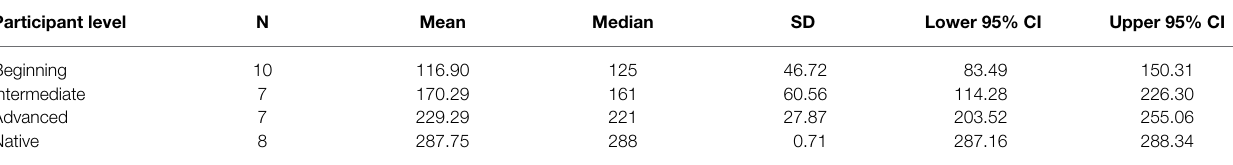
TABLE 1 | Descriptive statistics of EI test scores.